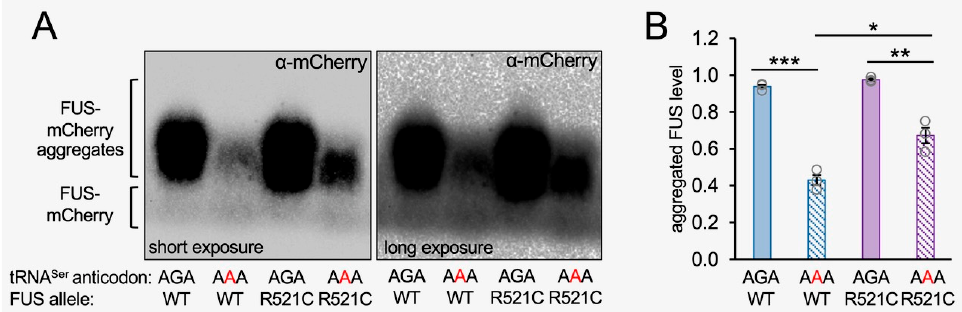
Figure 7. Analysis of total FUS protein aggregate levels in N2a cells expressing wild-type or mistranslating tRNA. Lysates from N2a cells transfected with a plasmid encoding human tRNA SerAGA or tRNA SerAAA and FUS-mCherry or FUS R521C-mCherry were collected at 72 h post-transfection, separated on ( A ) SDD-AGE gels, and Western blotted using an mCherry antibody; short (left panel) and long (right panel) exposure images of the blot are shown. ( B ) The fraction of aggregated FUS protein in the SDD-AGE blots was determined by densitometry. Error bars represent the mean ± 1 standard deviation of at least three biological replicates. Significant differences from pairwise independent sample t-tests are indicated (* p < 0.05, ** p < 0.01, *** p < 0.001). While our live-cell imaging data indicated a similar number of FUS R521C aggregates per cell in cells expressing wild-type versus mistranslating tRNAs at the end of the time course (Figures 6D and S6B), at 72 h post-transfection in our SDD-AGE experiment, we observed a somewhat reduced level of aggregated FUS R521C in the total population of cells transfected with mutant tRNA that was 75% of the total FUS R521C aggregation level